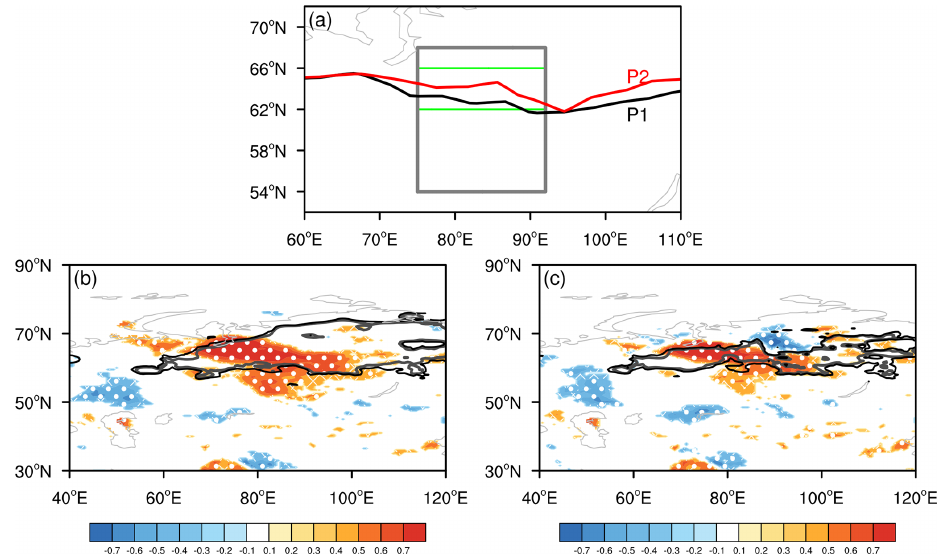
Figure 4. (a) The southern edge of the 85% snow cover concentration during 1980–1993 (black) and during 2004–2018 (red). The gray (green) box represents the key area used to calculate NHF WS (SC WS ) index. The correlation coefficients between SC WS ×− 1 and (b) surface net radiation flux (shortwave + longwave) and (c) surface net heat flux (latent + sensible) are displayed during 1980–1998 (shading) and 1999–2018 (contour). White dots (hatching) indicate the correlation coefficients during P1, exceeding the 95% (90%) confidence level ( t test). The gray (black) contours represent the correlation coefficients during P2, exceeding the 95% (90%) confidence level. The linear trend is